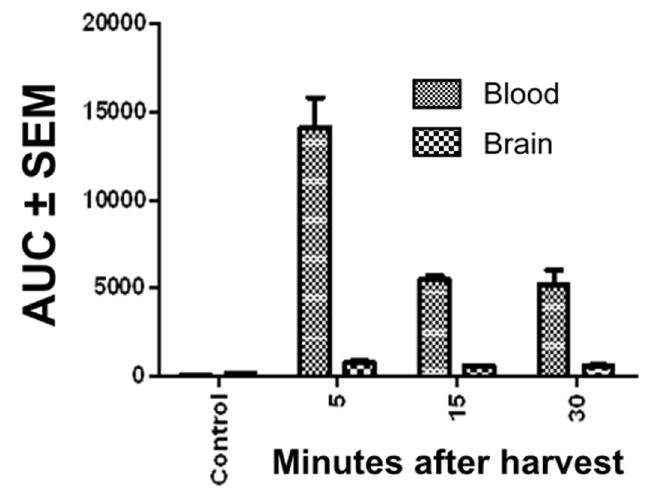
Figure 4. Opioid antagonist activity of 1968-22 in the 55 °C warm-water tail-withdrawal assay. ( A ): Mice were pretreated with 1968-22 (0.3 nmol., i.c.v.) 2 h prior to the administration of the MOR-preferring agonist morphine (10 mg/kg., i.p.), the KOR-selective agonist U50,488 (10 mg/kg., i.p.), or the DOR-selective agonist SNC-30 (100 nmol, i.c.v.) to assess potential antagonism through the reduction of the antinociceptive effect of the opioid agonist. ( B ): 1968-22 dose-dependently antagonizes SNC-80. Mean % antinociception ± SEM from eight mice for each bar. * significantly different from response of agonist alone ( p < 0.05); ( A ) two-way ANOVA or ( B ) one-way ANOVA with ( A ) Tukey’s or ( B ) Dunnett’s multiple comparison post hoc test.